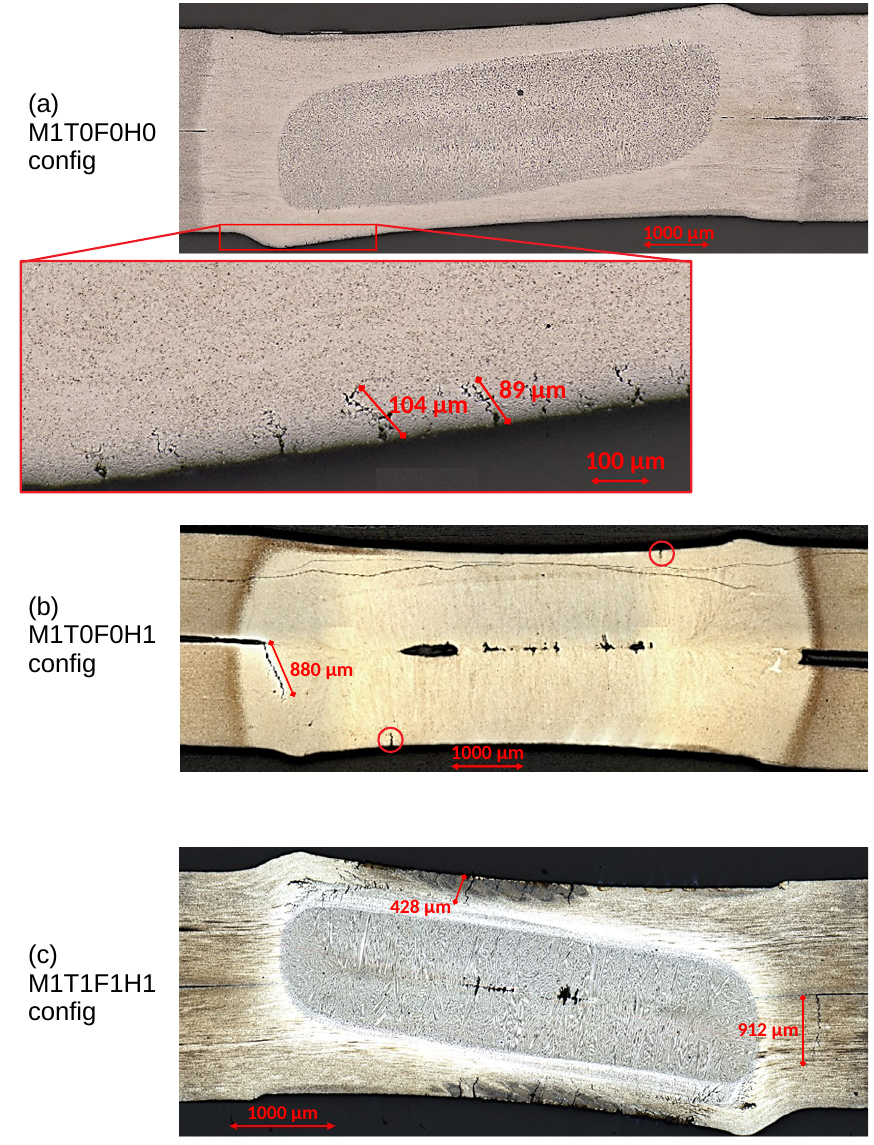
Figure 5. Metallographic cross-sections. ( a ) Outer cracks, ( b ) inner cracks and ( c )